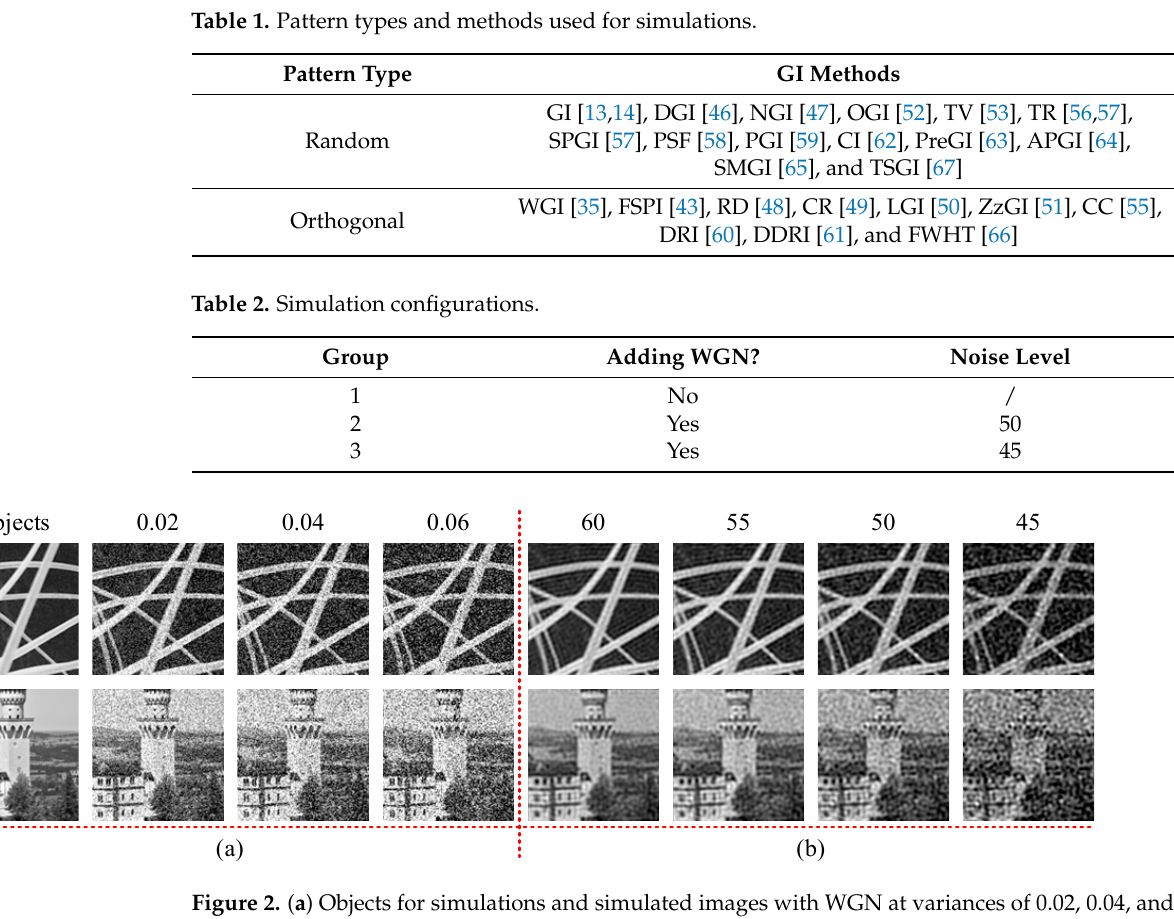
Table 2. Simulation